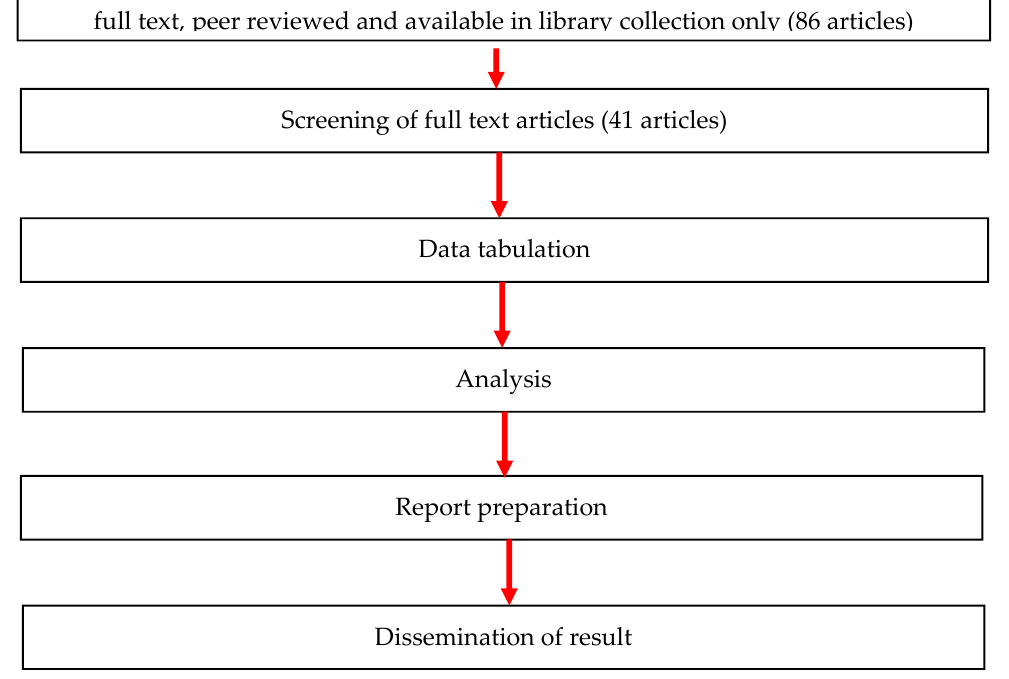
Figure 2. PRISMA flow diagram of the identification of literature for inclusion in this review.